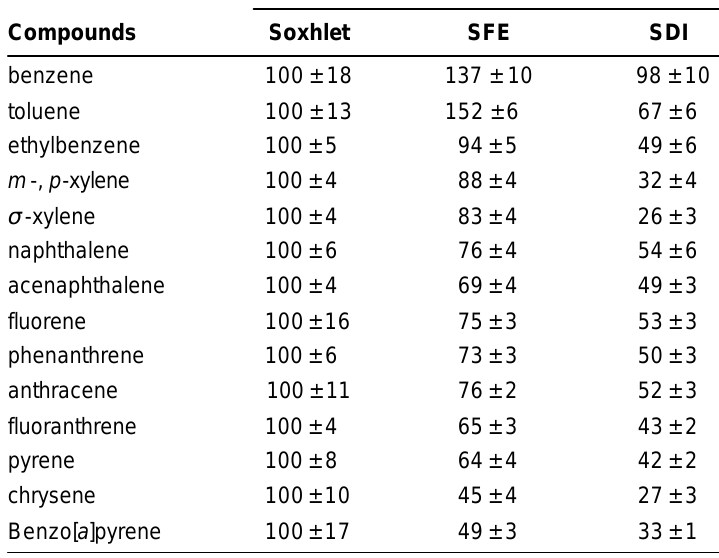
Comparison of Extraction Efficiencies (%) of Soxhlet, SFE, and Field-based (SDI) Solvent Extraction for Recovery of BTEX and PAH Compounds from Spiked Soil